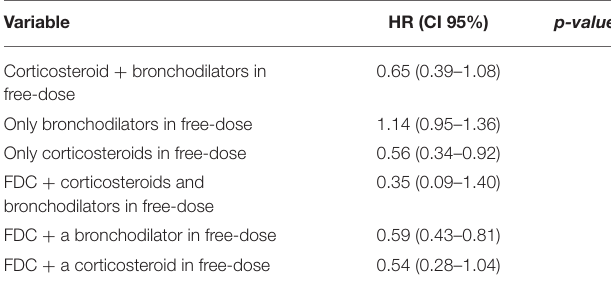
TABLE 2 | Univariate analysis of baseline characteristics associated with survival in COPD in the matched